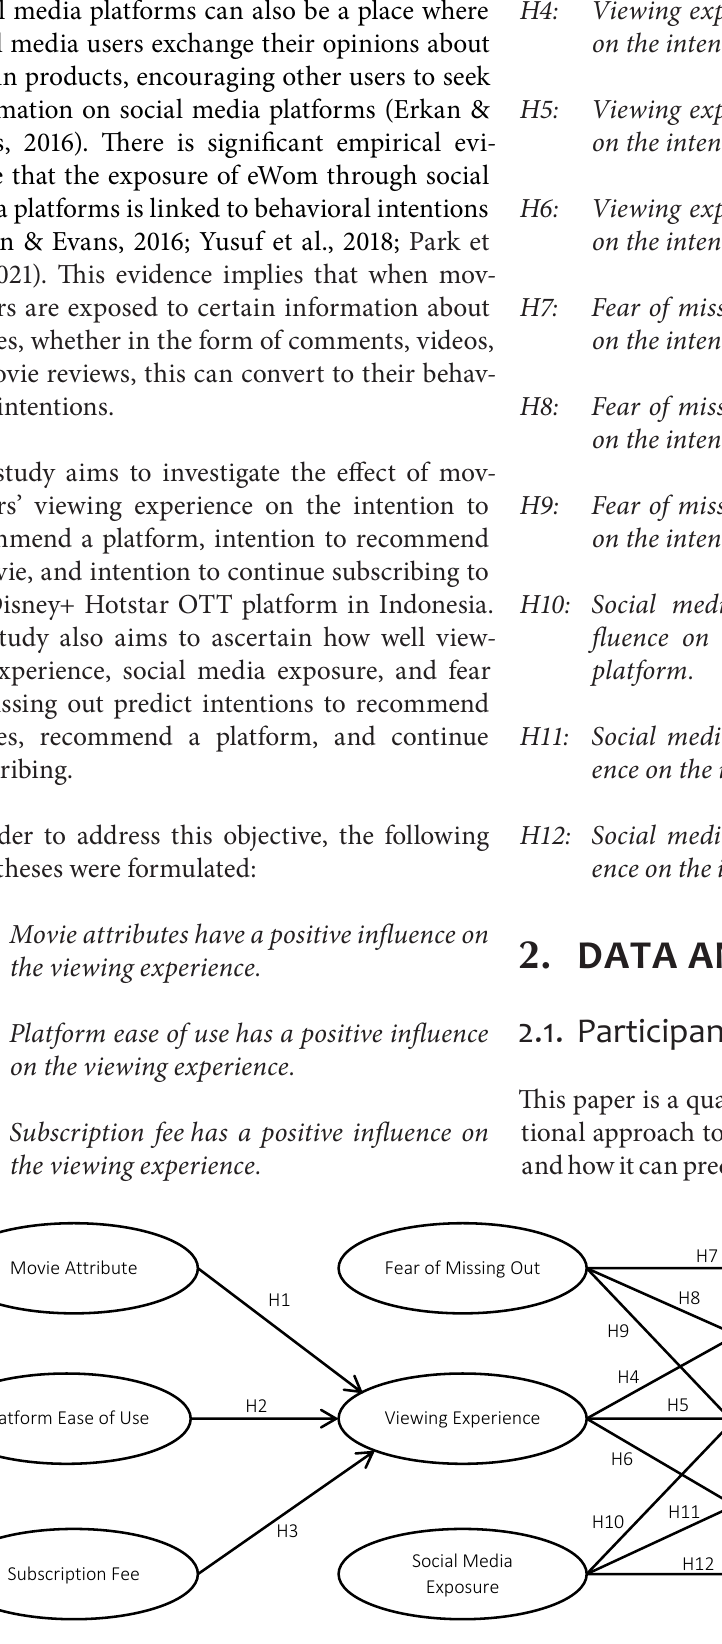
Figure 1. Conceptual